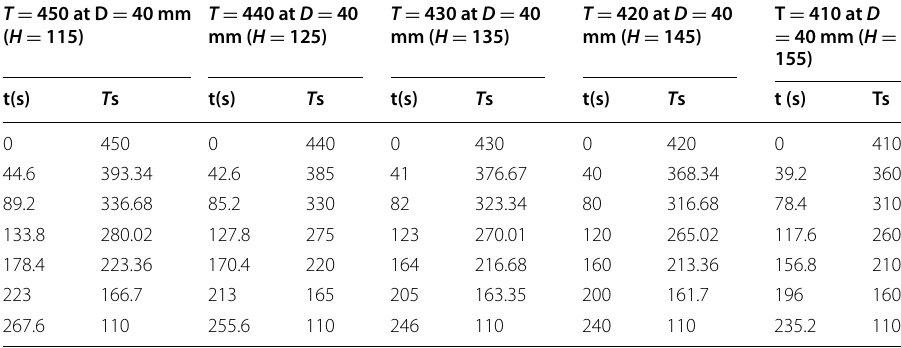
40 mm variant T and H for W-JIC = 40 mm =